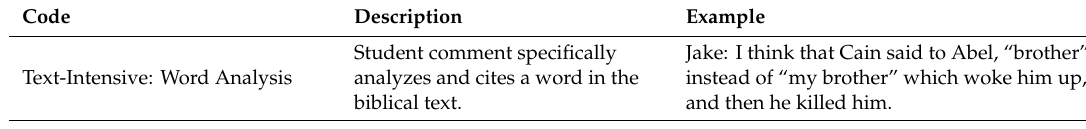
Table A2. Codebook for